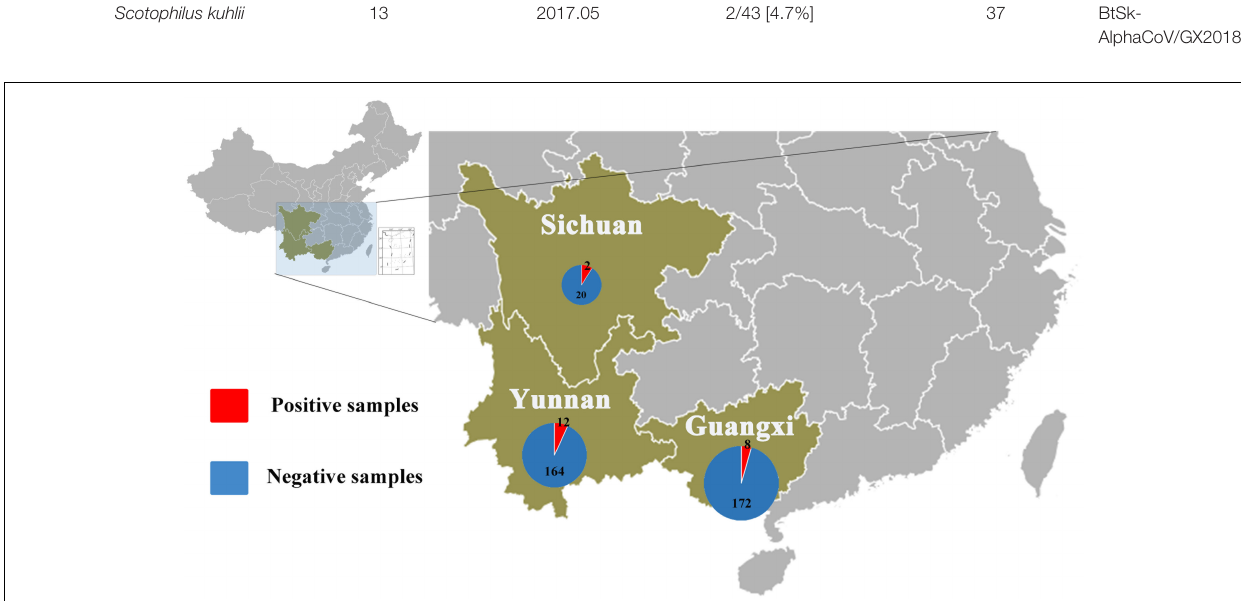
FIGURE 1 | Numbers of bat samples from Sichuan, Yunnan, and Guangxi Provinces. The size of the pie chart is in proportion with the total number of specimens collected from each province. Red color represents samples positive for CoV, and blue color represents negative samples.